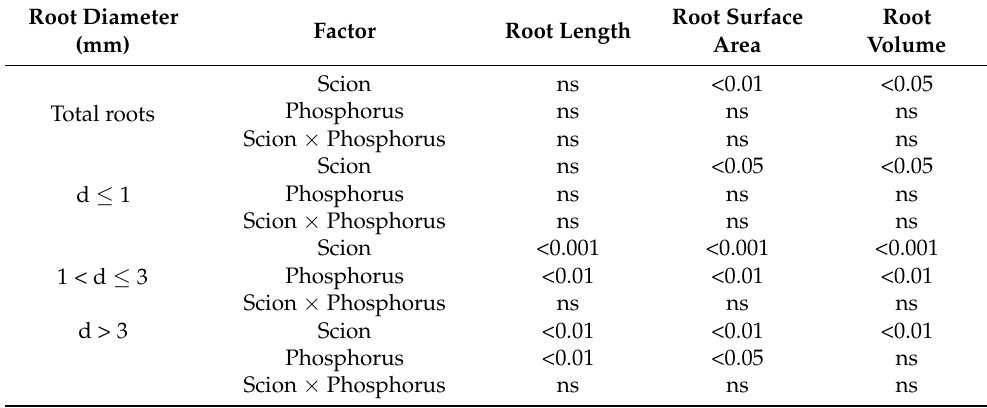
Figure 2. Root dry weight (RDW) ( a ), shoot dry weight (SDW) ( b ), total DW (TDW) ( c ), and root- to-shoot ratio (RDW/SDW) ( d ) of the scions (W2, G8, and G83-1) grafted onto W2 rootstock under control (0.5 mM) and low-P (0 mM) conditions during eight months. Lowercase and uppercase indicated significant differences among grafted combination under controls and the low-P supply treatments, respectively. * and ** in the figure legend indicated significant effect of Scion, P, and their interaction at level of p ≤ 0.05 and p ≤ 0.01, respectively. ns, no significant different between treatments. * on the bar indicated significant differences between control and low-P treated plants ( α = 0.05%). Table 1. Two-way ANOVA on the effects of scion cultivars, P availability, and their interaction on root length, root surface area, and root volume ( p -values) for roots of diameters (d) ≤ 1 mm, 1 to 3 mm, and >3 mm (ns,